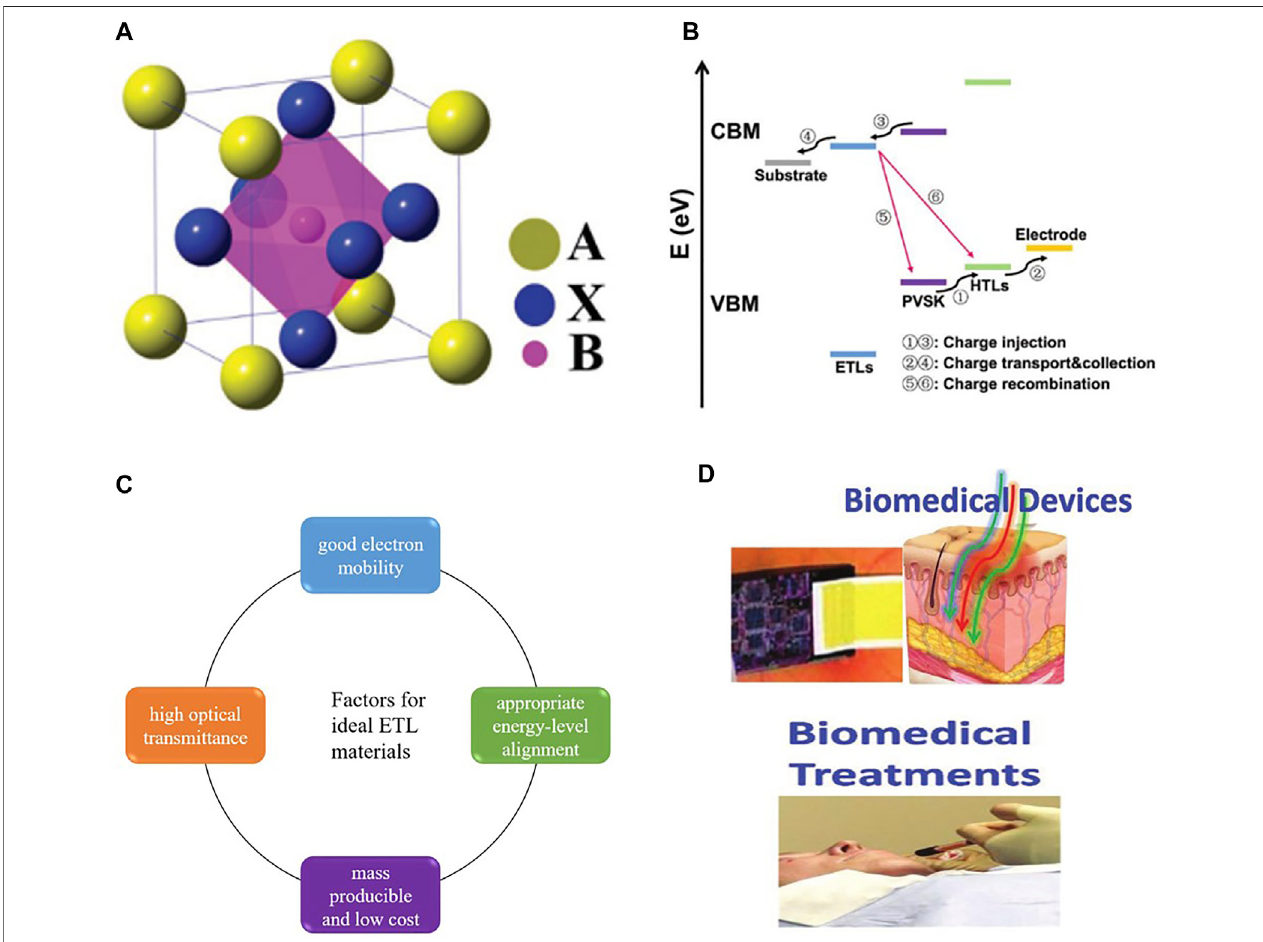
FIGURE 1 | (A) Perovskite crystal structures with the general formula of ABX 3 . (B) Schematic diagram of the charge transfer process in ETL. (C) Factors for ideal ETL materials. (D) Applications of PSCs in biomedical devices and biomedical